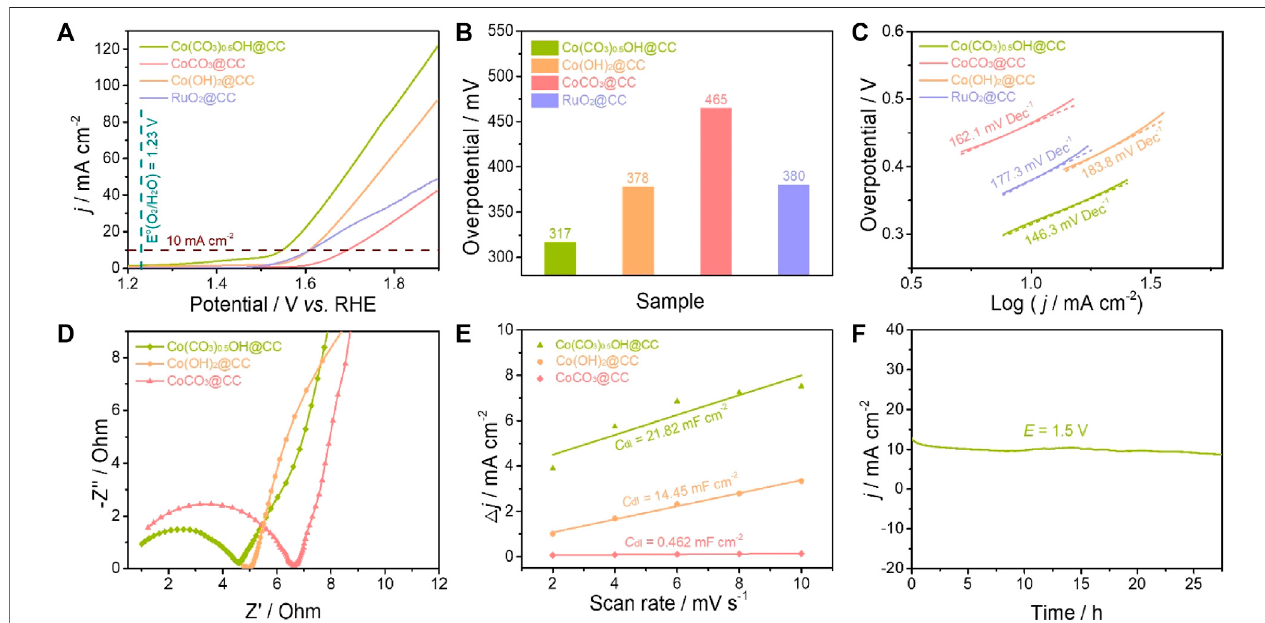
FIGURE4| ComparisonoftheOERactivityofcatalysts: (A) OERpolarizationcurvesinO 2 -saturated1.0 MKOH; (B) Overpotentialsat10 mA cm − 2 ; (C) Tafelplots; (D) EIS Nyquist plots; (E) C dl values of catalysts; (F) The chronopotentiometry curve of Co(CO 3 ) 0.5 OH@CC obtained at 1.5 V.